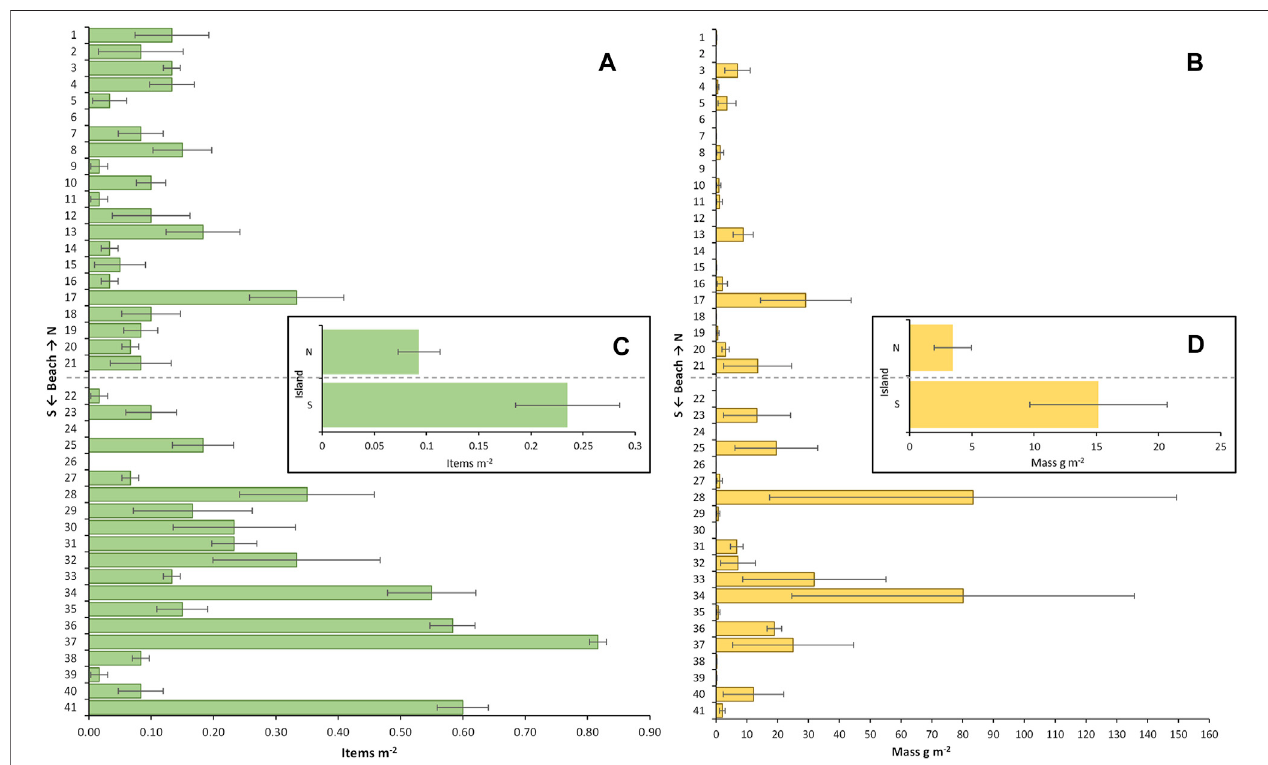
FIGURE 2 | Mean Anthropogenic Marine Debris ( > 2 mm) Across New Zealand Beaches by (A) Density ( ± SE), and (B) Weight ( ± SE); and Across Islands by (C) Density ( ± SE), and (D) Weight ( ± SE).